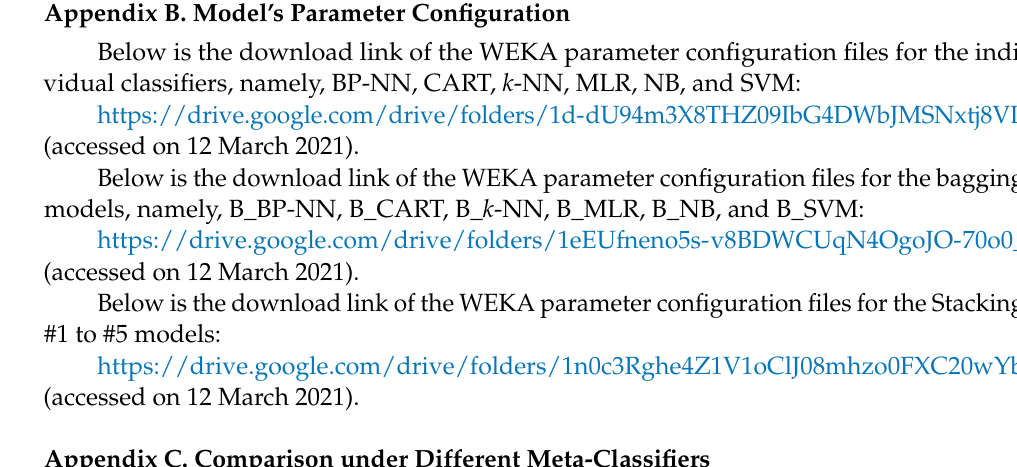
Table A2. Overall accuracies and kappa values of the stacking methods using different meta-classifiers and base classifiers.